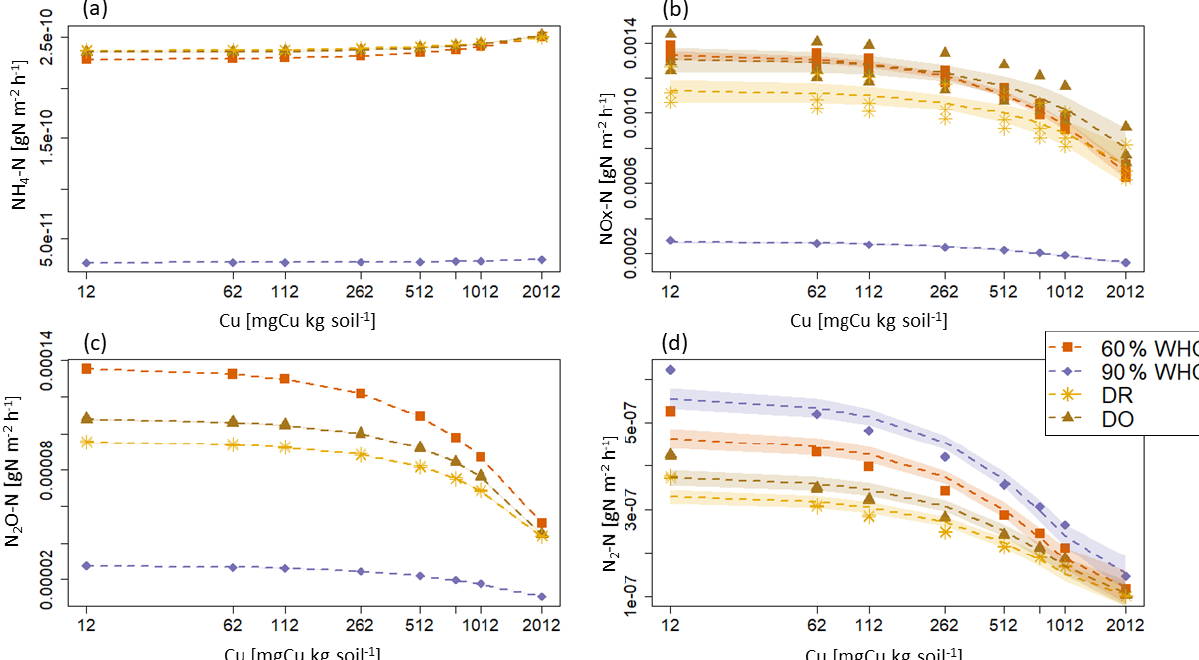
Figure 5. Modelled N emission fluxes at 3d in gNm − 2 30min − 1 under the different moisture treatments. (a) NH 4 -N emission fluxes. (b) NO x -N emission flues, (c) N 2 O-N emission fluxes and (d) N 2 -N emission fluxes. The purple diamond is for 90% WHC, red square for 60% WHC, brown star for Dry-Rewet (DR) and yellow triangle for Dry-Only (DO). Fluxes were modelled for 12, 62, 112, 262, 512, 762, 1012 and 2012mgCukg − 1 of soil as represented by stars. Quadratic fits were used for